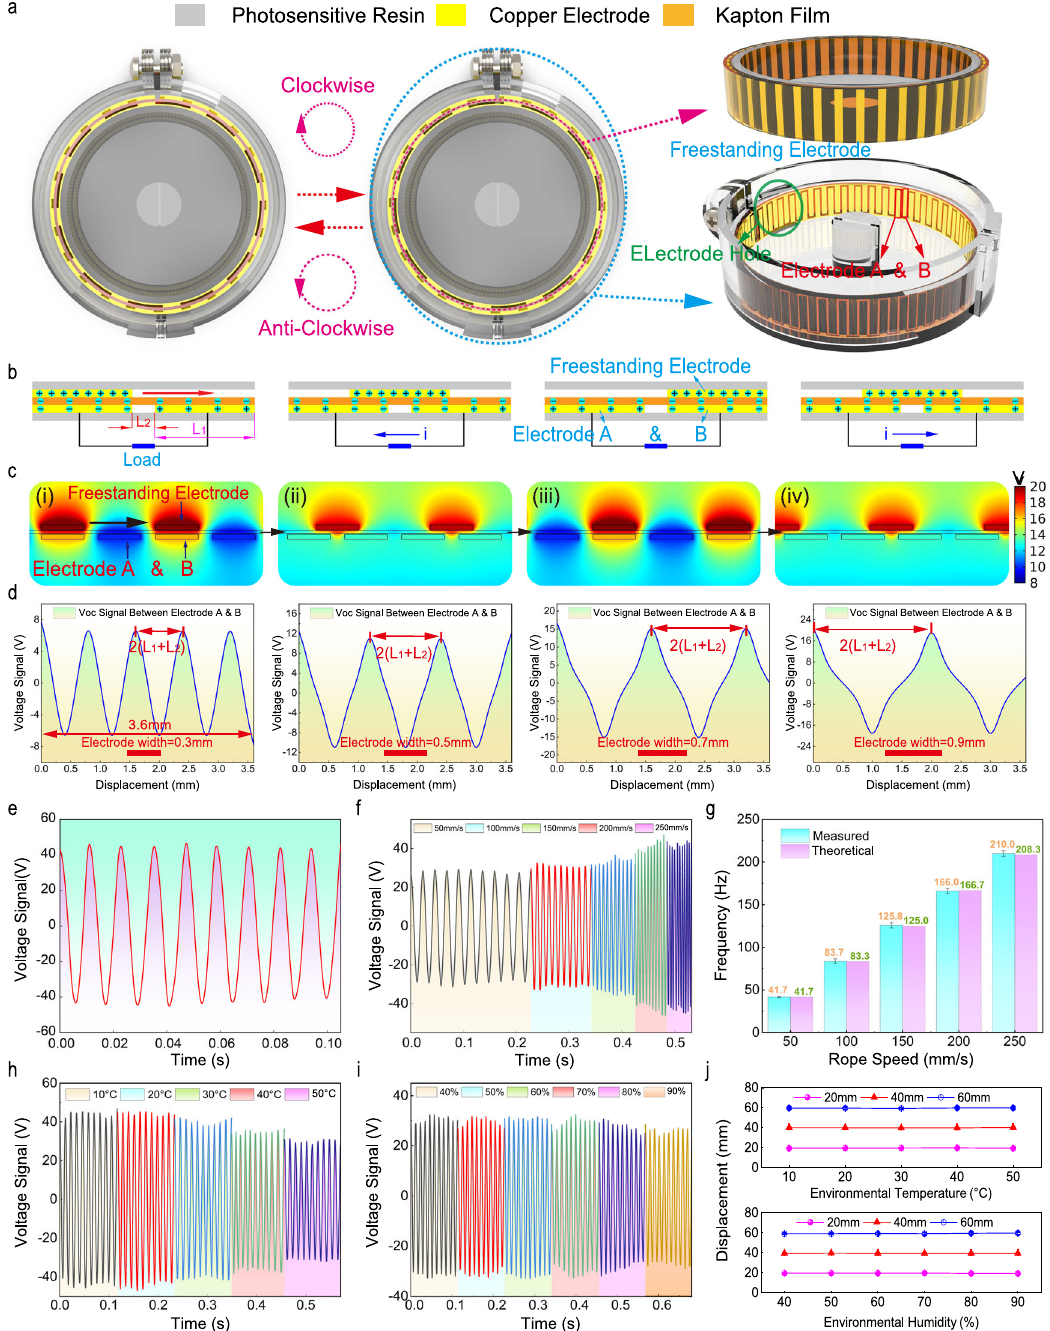
Fig. 2 The working principle, output performance, and characteristics of temperature and humidity of the device. a A top view of the stretch sensor when rotating clockwise and anticlockwise, and the right side of the image indicates the detail of the device ’ s 3D structure. b Schematic diagram of the working mechanism of the stretch sensor based on freestanding triboelectric nanogenerators (TENG). c Potential simulation of one working cycle by FEA with 0.3-mm electrode width, and ( d ) the simulated results of the open-circuit voltage with different electrode widths 0.3, 0.5, 0.7, and 0.9 mm. e The basic electrical output characteristic diagram of the stretch sensor with 0.5-mm electrode widths. f Voltage signals with different velocities from 50 to 250 mm s − 1 under a given displacement (36 mm) and g represents the theoretical and measured frequency corresponding to different velocities. h – i The output performance of the sensor at different environmental temperatures and humidity, and its corresponding displacement accuracy is shown in j . All error bars represent standard deviation based on ten replicate data under the same test condition. Source data are provided as a Source Data fi